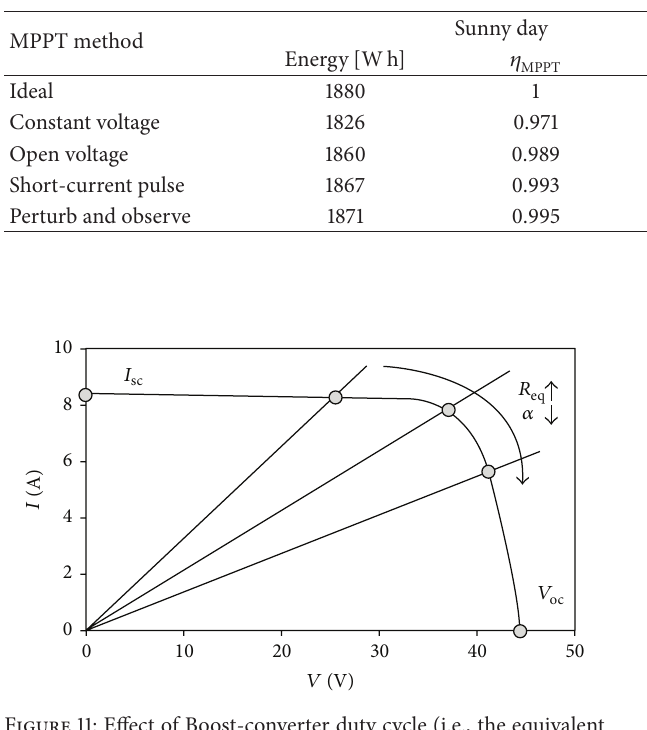
Table 2: Energy obtained from YL280C-30b monocrystalline solar panel calculated with ambient conditions measured at the Goddard Space Flight Center (GSFC) on May 13, 1971 (cloudy day), and May 14, 1971 (sunny day).